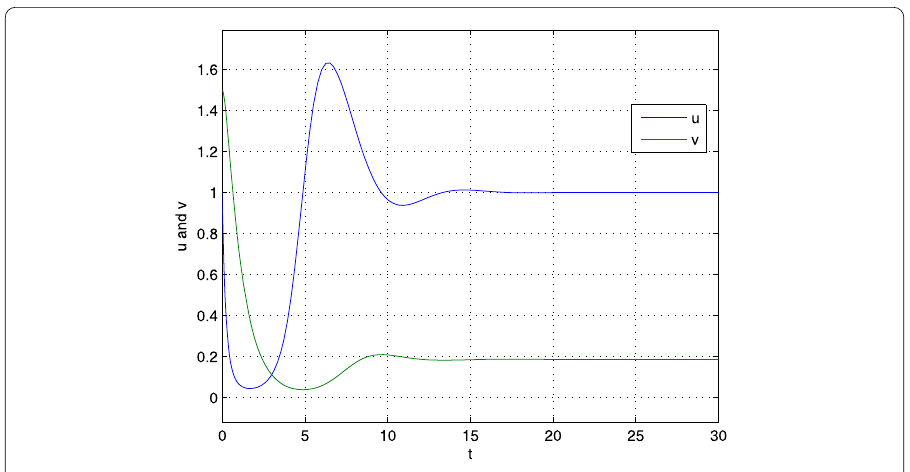
Figure 10 Dynamic behavior of system (1.1) with r 0 = 4, d = 1, a = 1, p = 2, E = 1, m 1 = 1, m 2 = 0.1, c = 0.5, k = 1, and q = 1.1